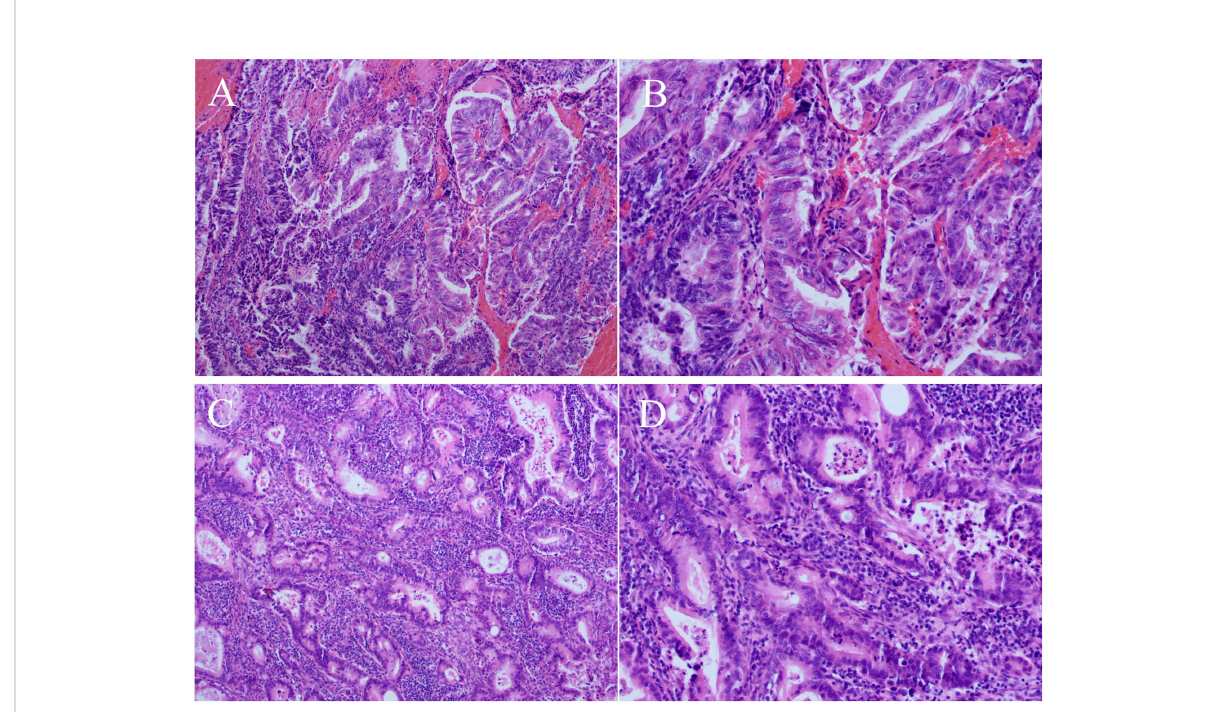
FIGURE 3 Histopathological fi ndings (hematoxylin-eosin staining). Well-differentiated adenocarcinoma of the cervix (A) , 100×; (B) , 200× and well- differentiated adenocarcinoma of the endometrium (C) , 100×; (D) ,